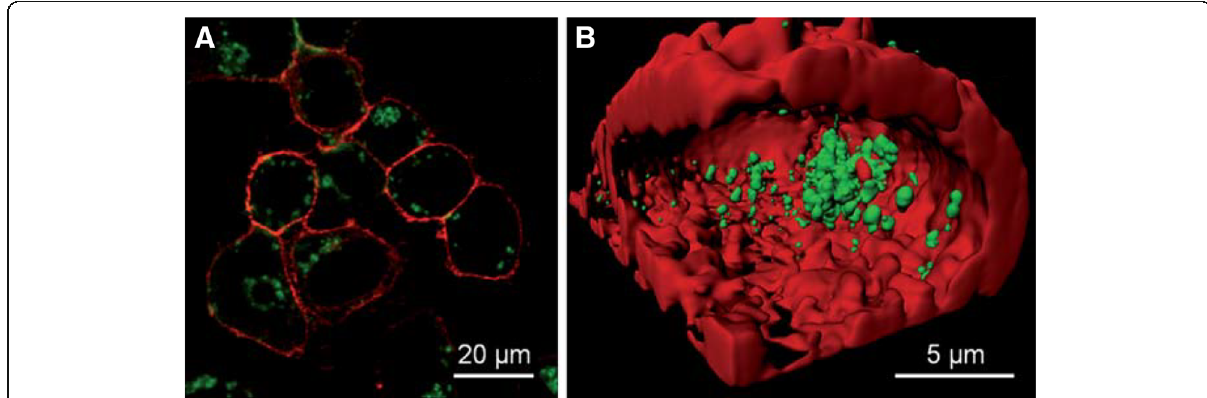
Fig. 1 a Image of HeLa cells after incubation with DPA-AuNCs for 2 h by confocal microscopy. b 3D Image displaying internalized DPA-AuNCs in cross-sectioned view [55]. The colors of DPA-AuNCs and membrane dye DiD are depicted in green and red,